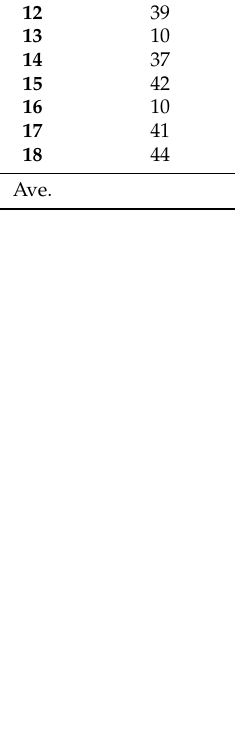
Table 4. Parameter confidence levels attributed to the effectiveness of the 128-slice CT acquisi- tion experiment. A parameter was considered significant if the corresponding confidence level exceeded 95%.